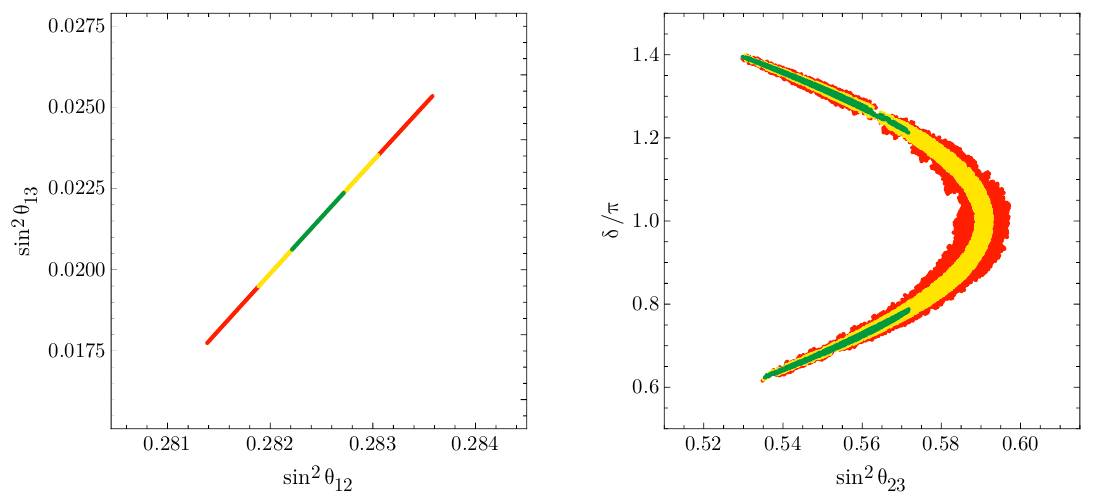
Figure 2 . Correlations between sin 2 (cid:18) 12 and sin 2 (cid:18) 13 (left) and between sin 2 (cid:18) 23 and (cid:14) (right) in the model with k Y = 4 and h (cid:28) i = i , in the vicinity of the viable point of eq. (3.11). The green, yellow and red regions correspond to 2 (cid:27) , 3 (cid:27) and 5 (cid:27) con(cid:12)dence levels,